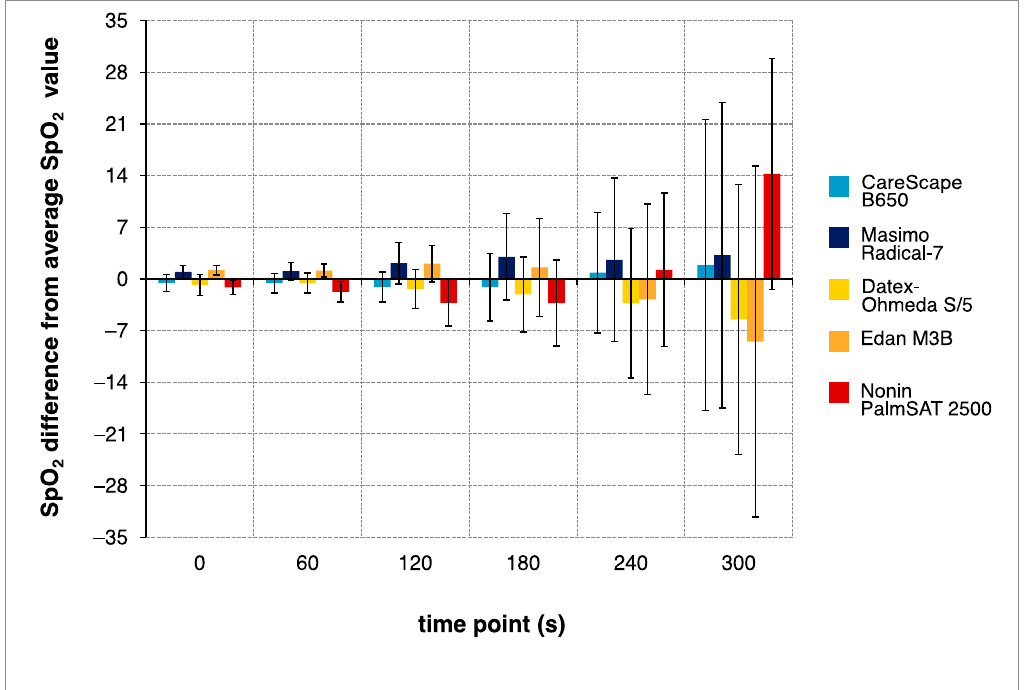
Figure 5. The difference of average SpO 2 value displayed by individual pulse oximetry devices and the average value of all pulse oximeters which represents ‘0’ on the y -axis. The difference is displayed at the beginning of the breathing phase (0 s), and at 60, 120, 180, 240 and 300 s. The error bars depict the standard deviation (SD). For example, at 300 s the Nonin PalmSAT on average read 14% higher than the average pulse oximeter reading with a SD